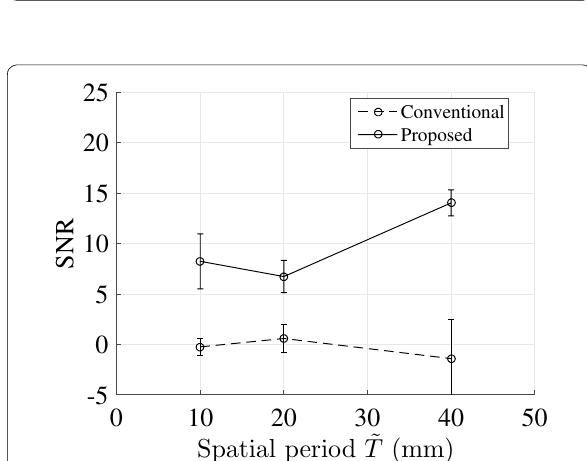
Fig. 11 Graph showing relationship between the period ˜ T and the SNR